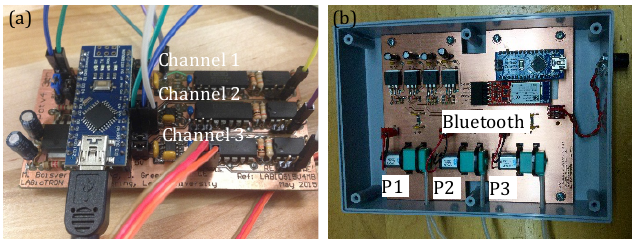
Figure S2. (a) 3-channel potentiostat where each channel is dedicated to Figure 6. ( a ) 3-channel potentiostat where each channel is dedicated to one measurement (serotonin, one measurement (serotonin, dopamine 1 and dopamine 2). (b) The dopamine 1 and dopamine 2); ( b ) The micropumping system of this platform consists of 3 channels micropumping system of this platform consists of 3 channels (P1, P2 and (P1, P2 and P3) controlled by peristaltic micropumps from dolomite. An embedded microcontroller P3) controlled by peristaltic micropumps from dolomite. An embedded (Arduino Uno) handle the control part of all electronic system. microcontroller (Arduino Uno) handle the control part of all electronic system.